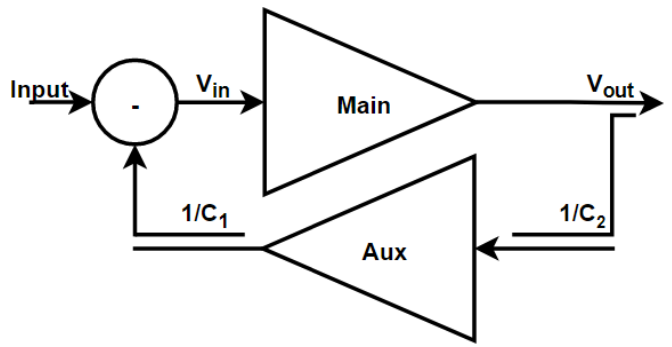
Figure 4. Active feedback operational diagram.